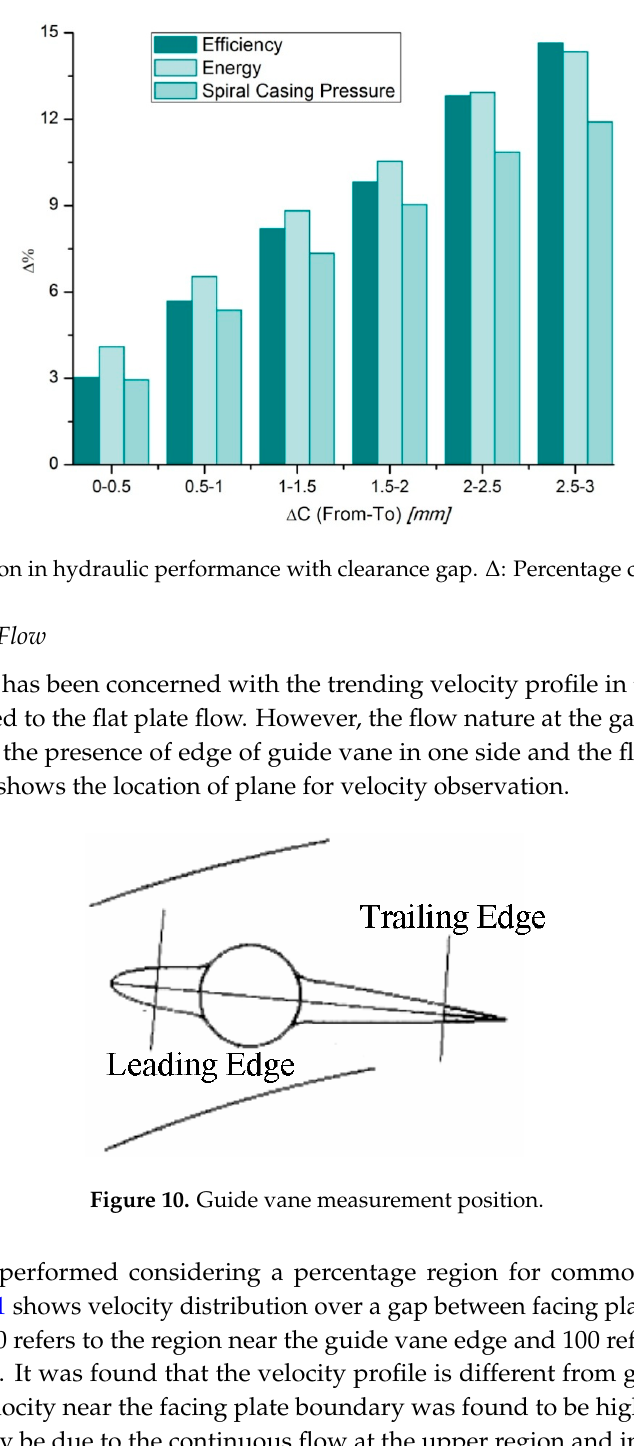
Figure 11. Velocity profile over the gap from button to top at leading edge. V: Velocity profile. Figure 12 shows the graphical representation of the velocity distribution in the trailing edge. Unlike the leading edge, the velocity distribution seems to be close in all the cases, although the decreasing pattern with increasing gap is similar. The stiffness pattern is also similar to the leading edge. The magnitude of the velocity distribution is higher compared to the leading edge because of the high acceleration with decreasing radius.